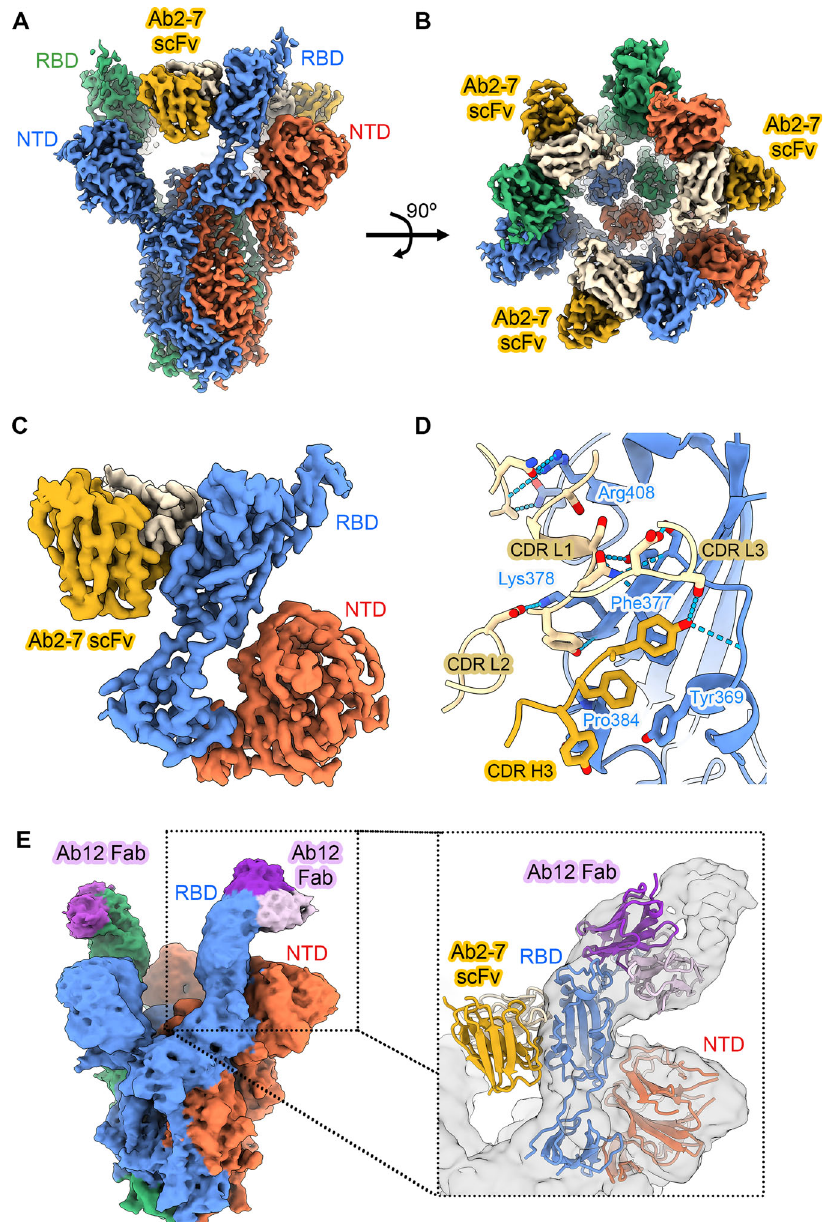
Fig. 2 | High resolution cryo-EM structure of Ab 2-7 scFv and Ab 12 Fab com- plexed SARS-CoV-2 S D614G.A Sideand ( B ) top views of acomposite 3Dcryo-EM reconstruction of Ab 2-7 scFvs bound to the receptor binding domains of SARS- CoV-2 spike ectodomains at 3.0Å resolution. Individual spike protein protomers are colored red, blue and green. The heavy chain of Ab 2-7 scFv is colored yellow, the light chain is colored tan. C Locally re fi ned 3D cryo-EM reconstruction of